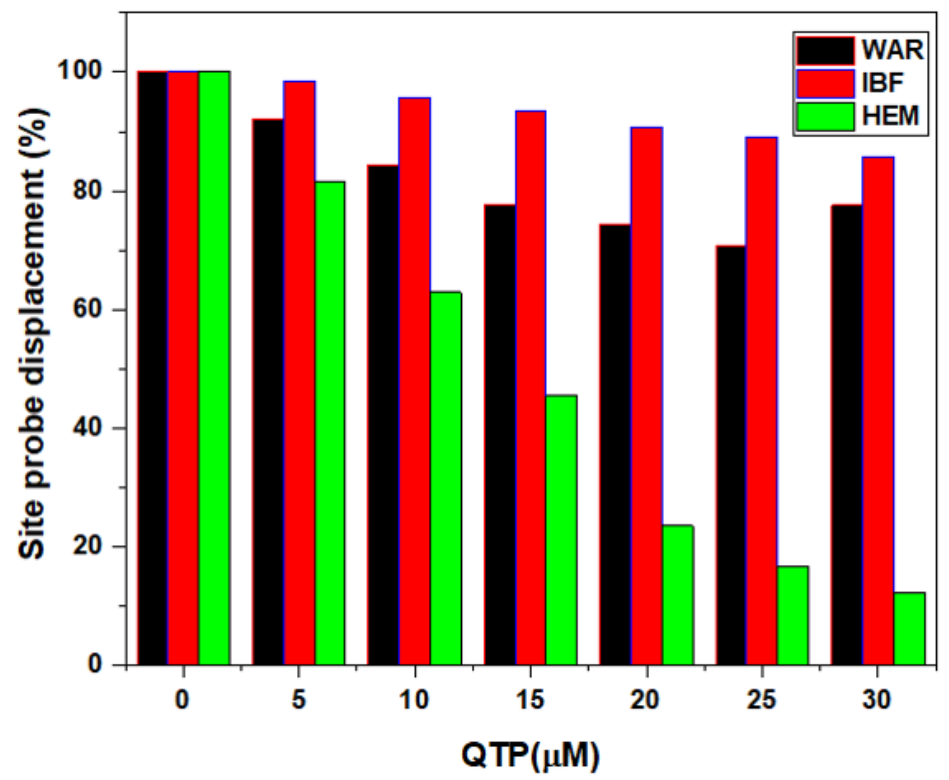
Figure 5. Effect of site probes on the fluorescence emission intensities of the HSA-QTP system. The experiments were carried out using three site probes (warfarin, ibuprofen, and hemin). (HSA = 5 µ M, QTP = 10 µ M, C = 0-30 µ M), λ ex = 295 nm, T = 295 K.